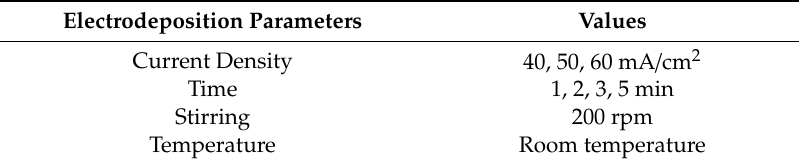
Table 3. Di ff erent parameters used for electrodeposition of the composite Cu–MoS 2 composite coating using composition of Table